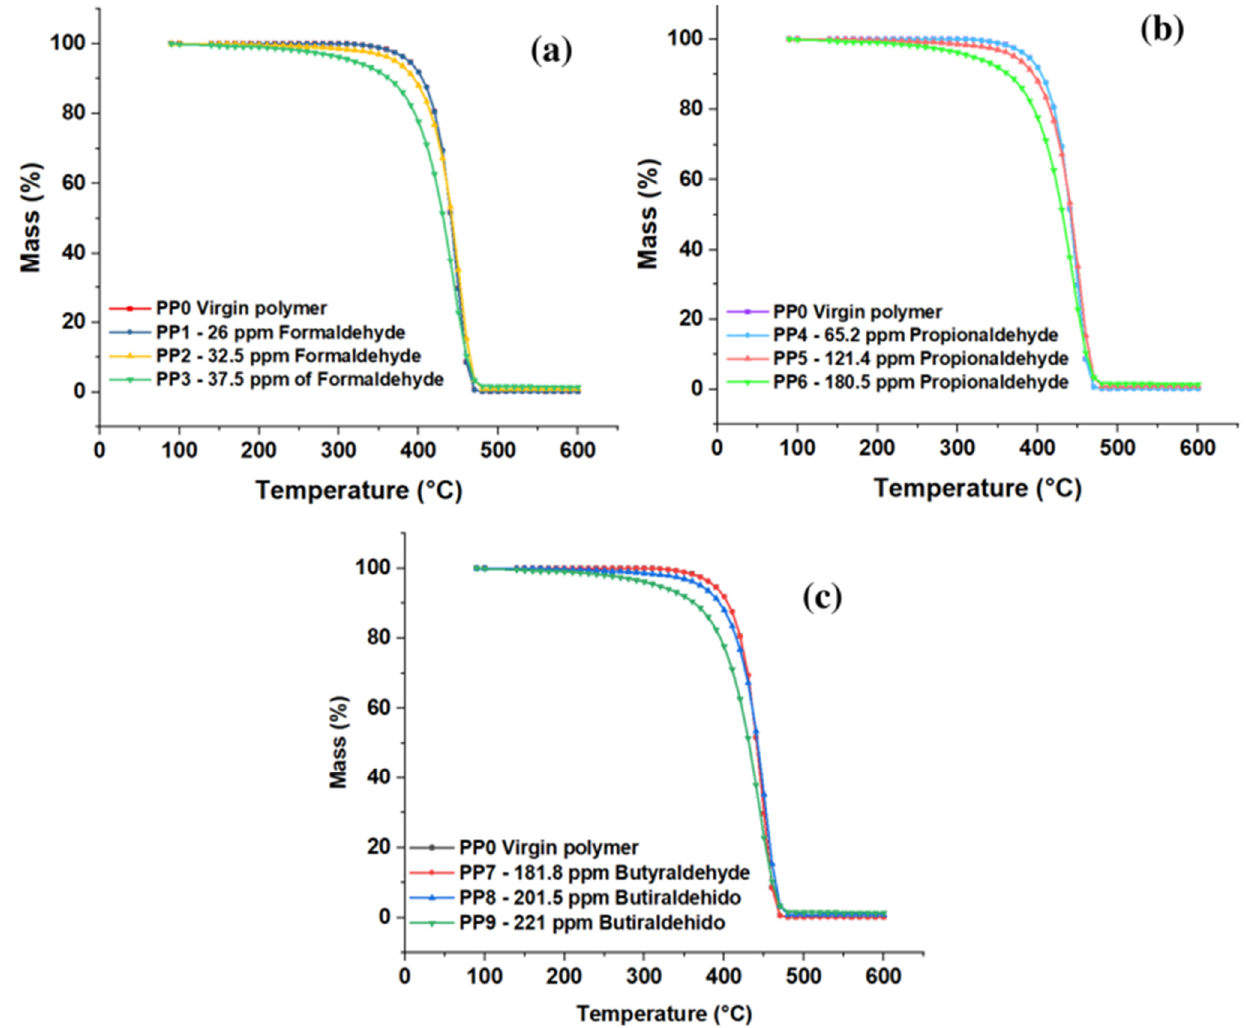
Figure 6. Effect of trace formaldehyde ( a ), propionaldehyde ( b ), and butyraldehyde ( c ) on the TGA of the copolymer.